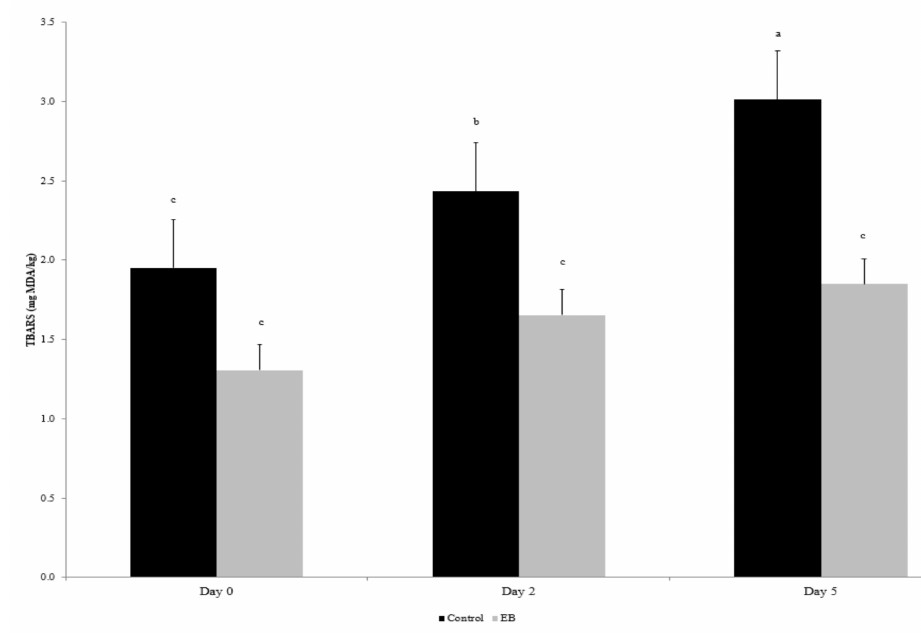
x,y,z Within row, different superscript letters indicate differences ( p < 0.05) between days of storage tested by using the Tukey’s adjustment for multiple comparisons. 1 Treatments were concentrate diet (control) and meat slices).